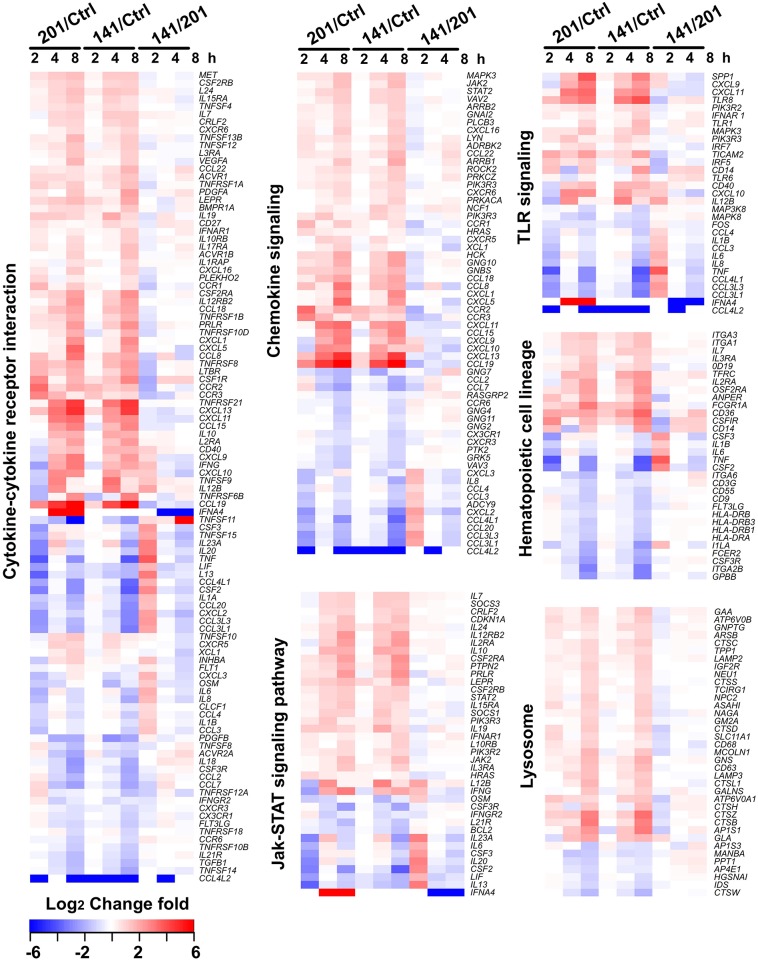
Gene expression patterns of the pathways that showing the significant differences between the Y. pestis 201- and 141-infected human peripheral lymphocytes. Some of the critical cellular pathways that were significantly enriched in the genes differentially expressed at 2, 4, or 8 hpi in 201- and 141-infected lymphocytes are shown (p < 0.05, Fisher's exact test followed by the Benjamini multiple testing correction). Changes of the differentially expressed genes are presented in different colors as shown in the color key.